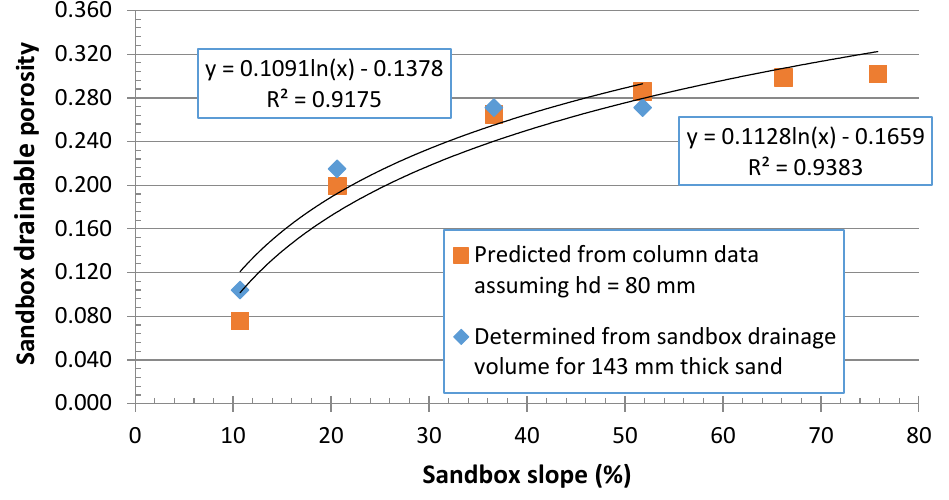
Figure 10. Predicted and measured drainable porosities as they depend on bedslope for 143 mm sand depth.